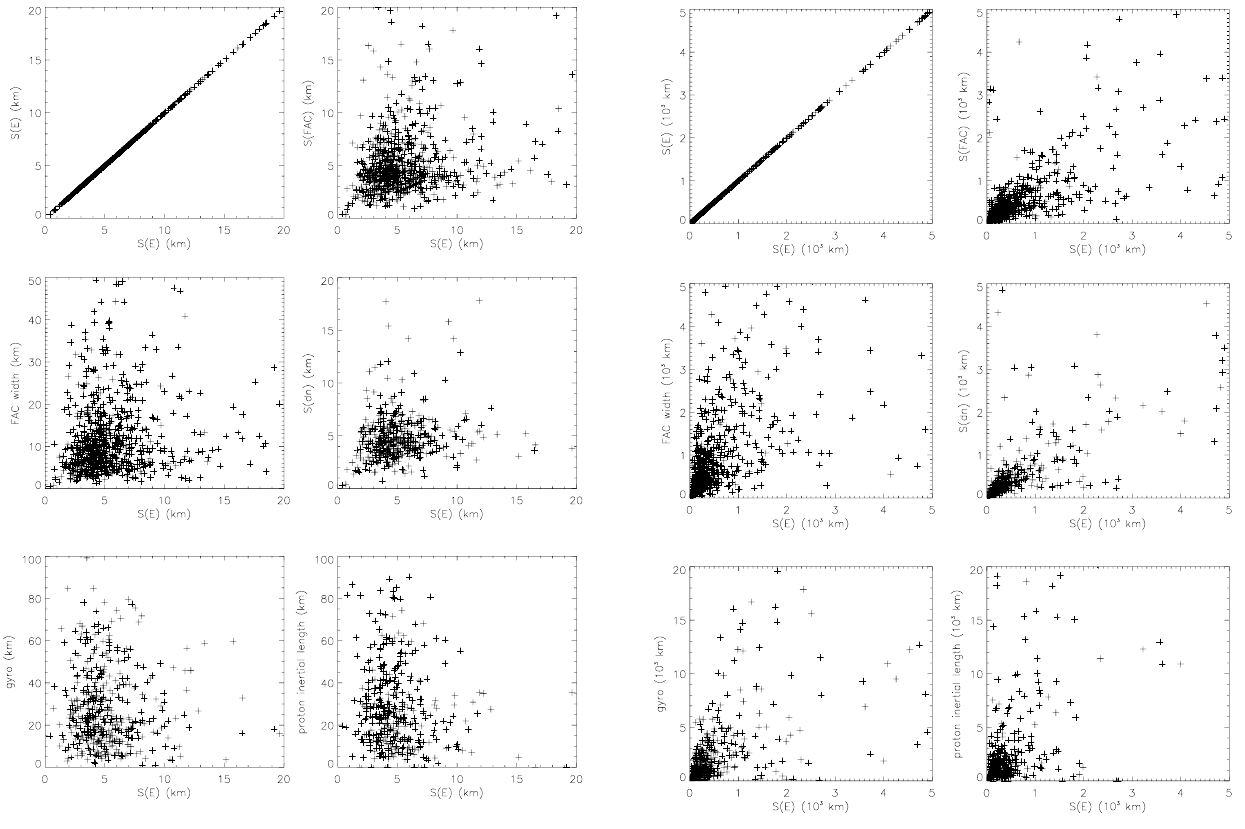
Fig. 4. Similar to Figure 3 but this time mapping to the equatorial